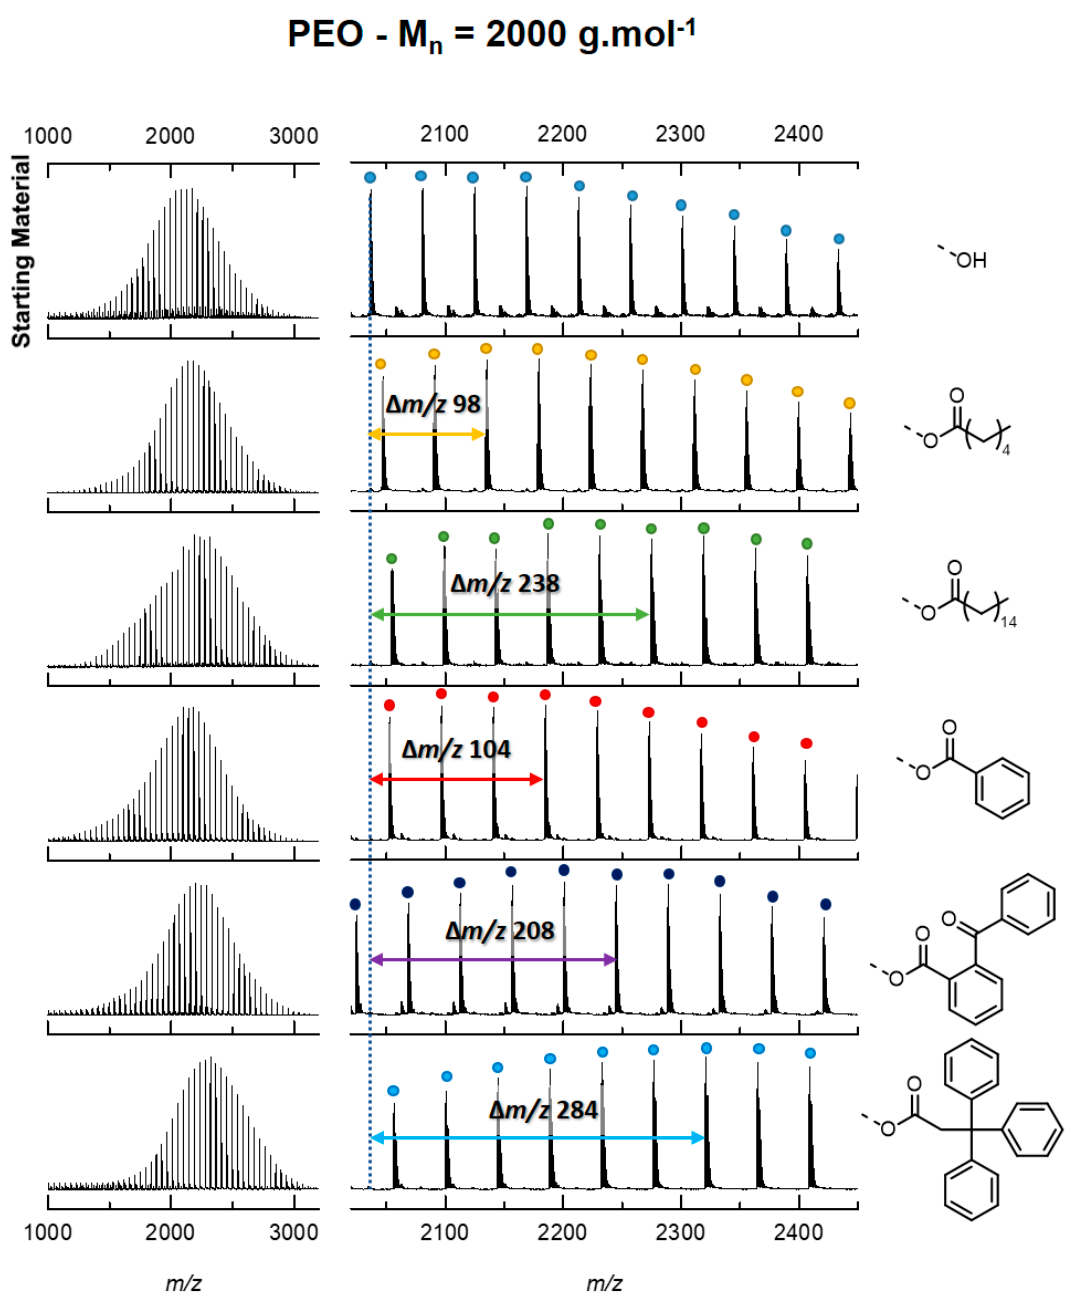
Figure 1. MALDI mass spectra recorded for functionalized and non-functionalized PEO with M n = 2000 g mol − 1 . Functionalization was attested by the appearance of additional signals with adequate mass differences compared to the α -methyl, ω -hydroxy PEO used as a starting material (top).